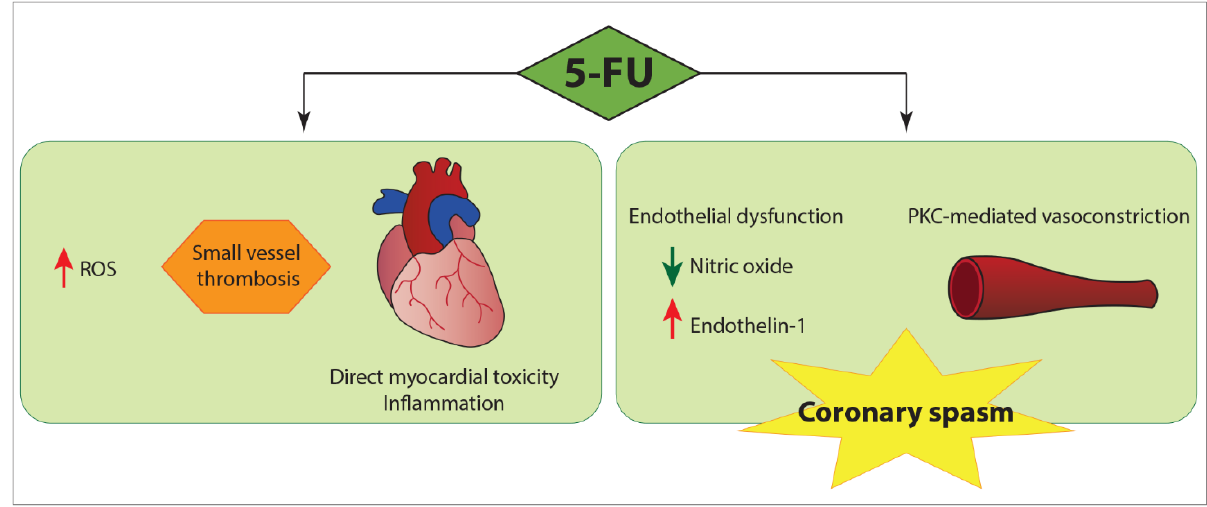
Figure 6. Possible mechanisms of 5-FU cardiotoxicity. Despite coronary vasospasm being the most well-established manifestation of 5-FU cardiotoxicity, a multifactorial mechanism has been postulated, involving both ischemia secondary to coronary vasospasm and direct myocardial damage. 5-FU, 5-Fluorouracil; PKC, protein kinase C; ROS, reactive oxygen species.